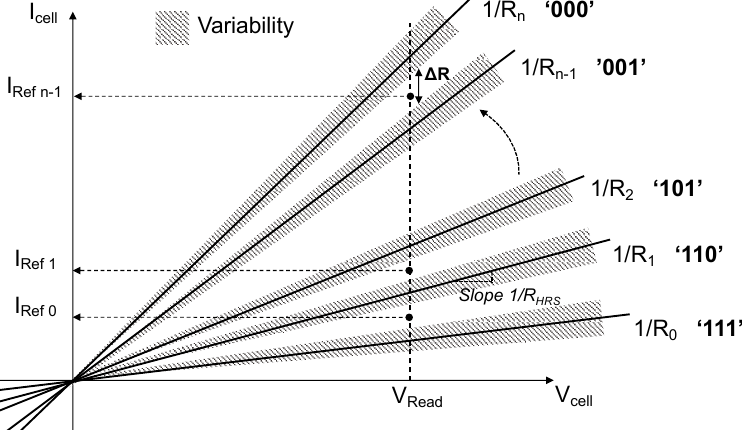
Figure 9. MLC allocation strategy and READ operation: the cell is read at V Read , and compared to fixed reference currents denoted by I Ref .